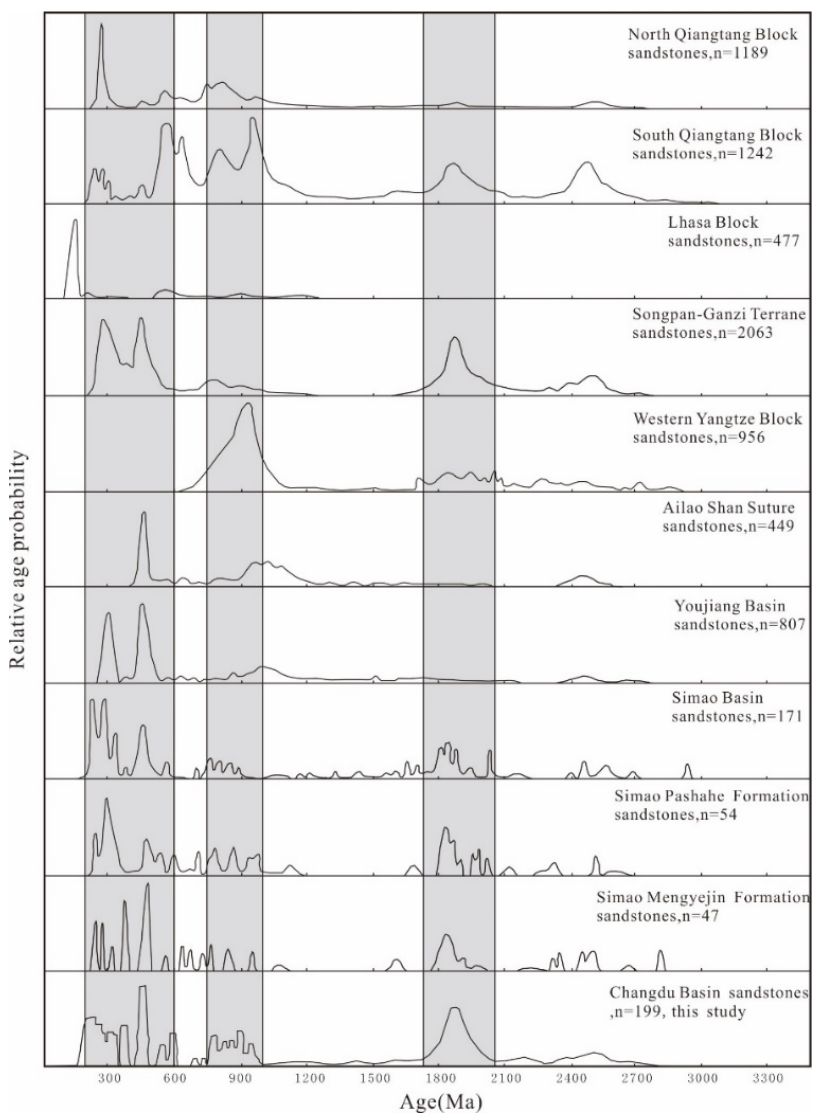
Figure 12. Probability density plots and histograms of LA-ICP-MS detrital zircon U–Pb ages of the Qamdo samples compared with those from Qiangtang (after Gehrels et al., 2011 [79]), Lhasa (after Leier et al., 2007 [80]), Songpan-Ganzi (after Weislogel et al., 2010 [81]), Yangtze (after Zhao et al., 2010 [82]), Ailaoshan (after Lai, 2012 [83]), Youjiang basin (after Yang et al., 2012 [84]), Simao basin (after Wang et al., 2014 [17]), and Pashahe and Myejing Formations (after Li et al., 2015